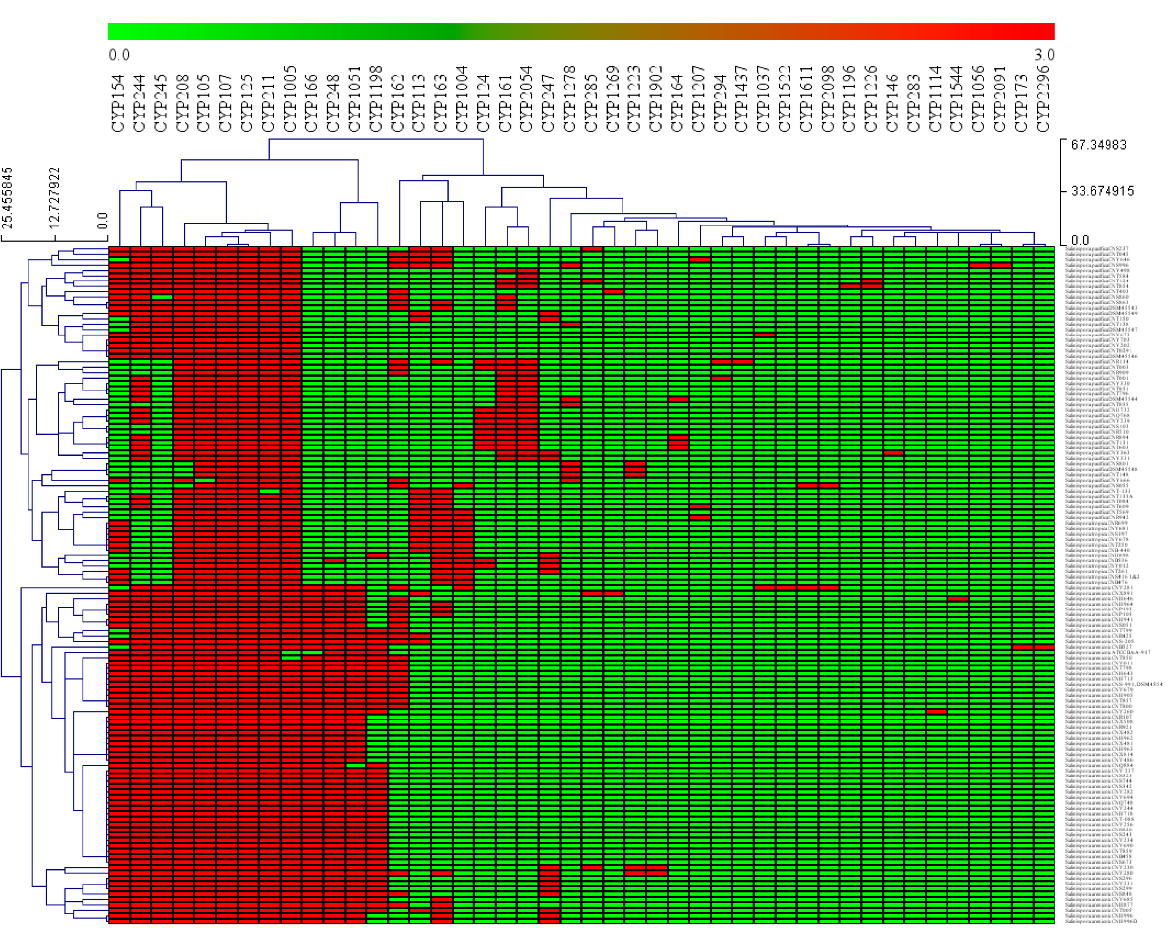
Figure 2. Heat-map of P450 family conservation or co-presence analysis in Salinispora species. In the heat-map, the presence and absence of P450 families are indicated in red and green colors. The horizontal axis represents P450 families, and the vertical axis represents Salinispora species.